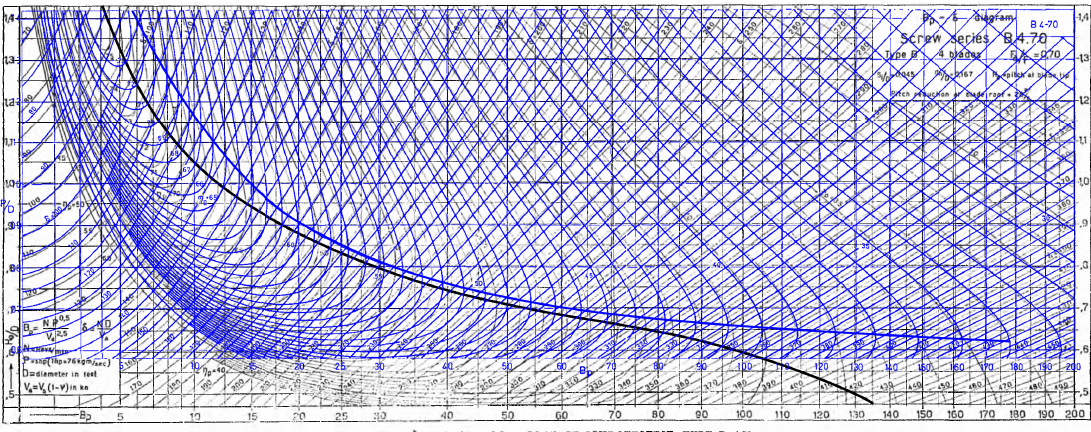
Figure 2. B p – δ diagram of propeller B4-70 based on the originally published values by van Lammeren and van Aken in 1949 ([original black print, Reynolds number = 2.72 · 10 5 ) and on the scaled and faired open-water characteristics by van Lammeren et al. in 1969 (blue, Reynolds number = 2 · 10 6 ). √ P P / v 2.5 a and δ = N · D / v a , where N = shaft Note the different lines for η o , max (in bold). B p = N · speed (in min −1 ); P P = delivered power (in hp); v a = advance speed (in kn); and D = propeller diameter (in feet). Reproduced from [4,5], with permissions from SWZ|Maritime and Society of Naval